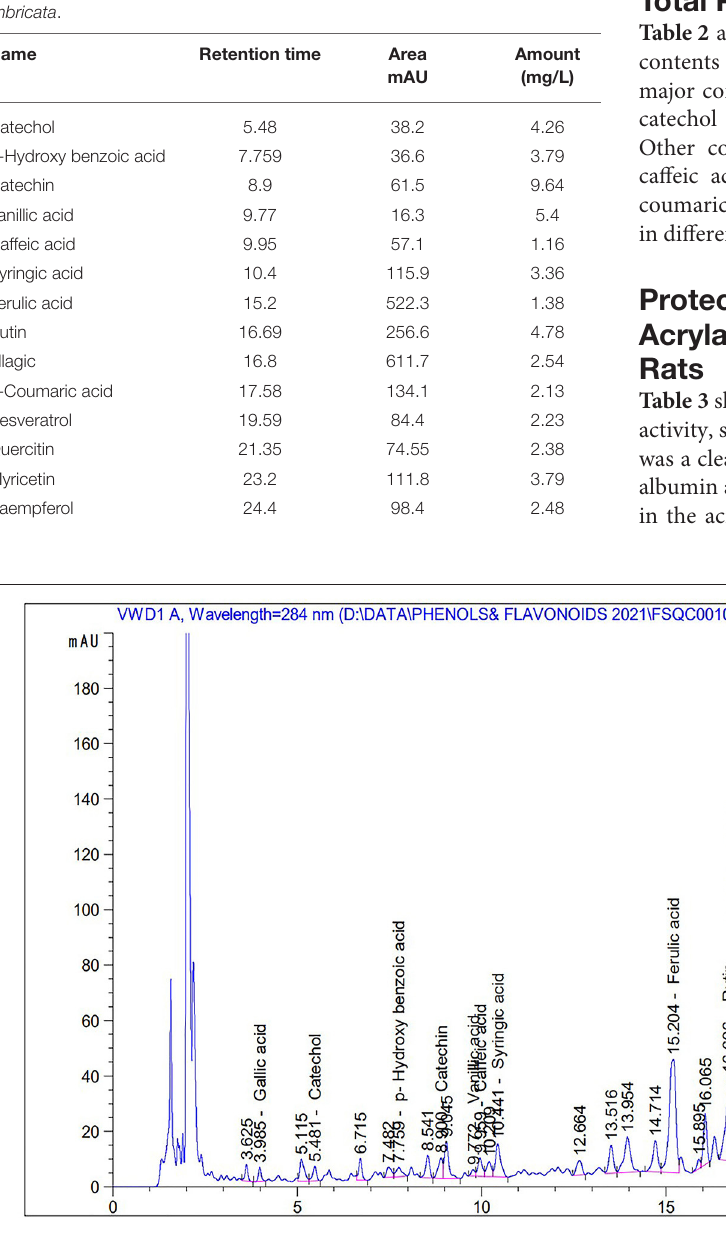
FIGURE 2 | Total phenols and flavonoids of an ethanolic extract of Salsola imbricata .